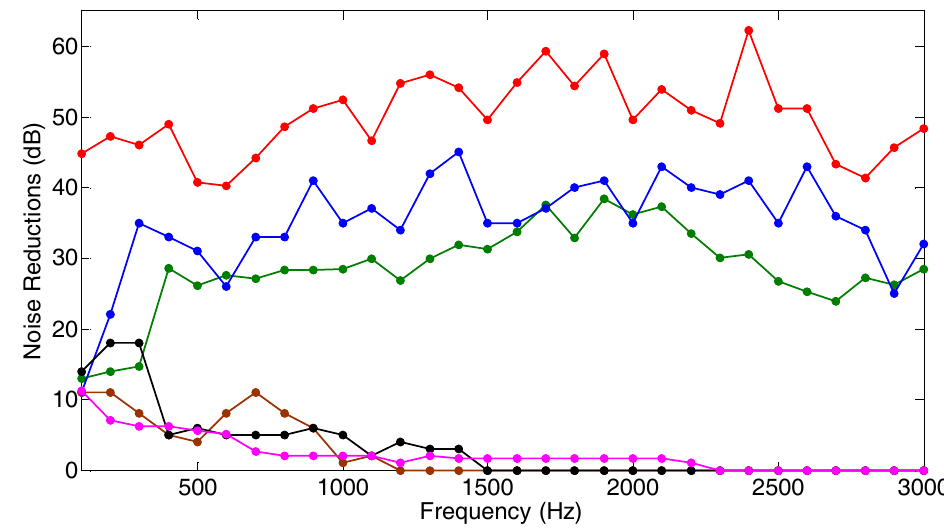
Figure 6. Reduction of tonal noise: clip (green), earbud (blue), and in ‐ ear (red); the commercial type A (brown), type B (black), and type C (pink) earphones.